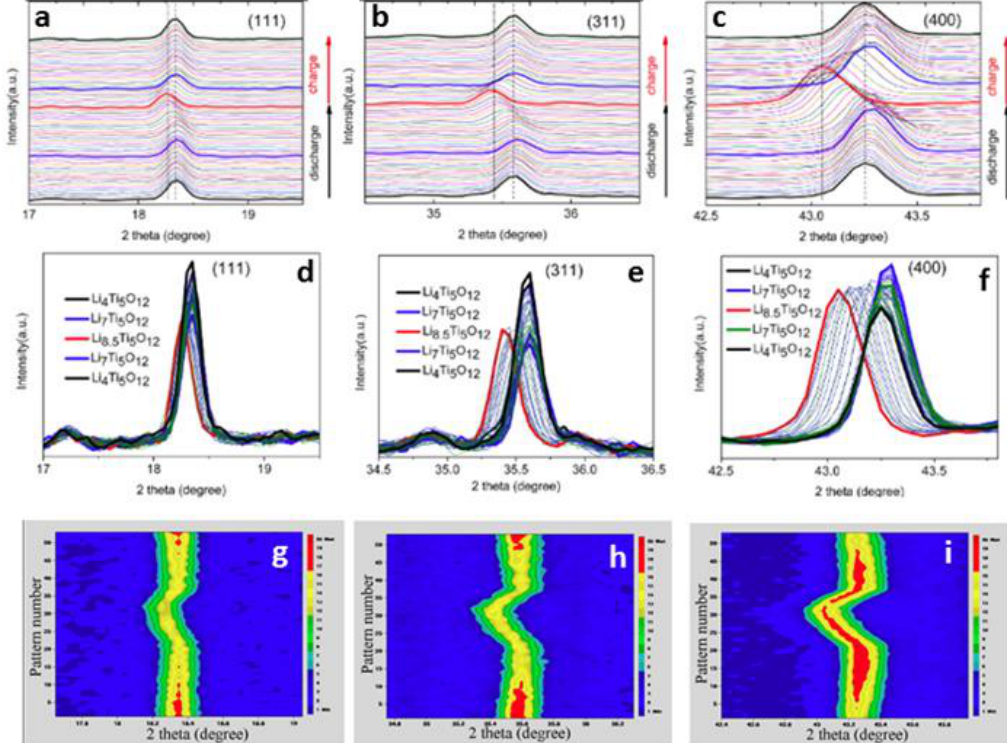
Figure 13. ( a – c ) Evolution of (111), (311) and (400) diffractions of Li 4 Ti 5 O 12 during the first discharge/charge between 3.0 and 0 V and their image plots ( g – i ). ( d – f ) Highlighted spectra with corresponding compositions [115]; with permission from ACS.